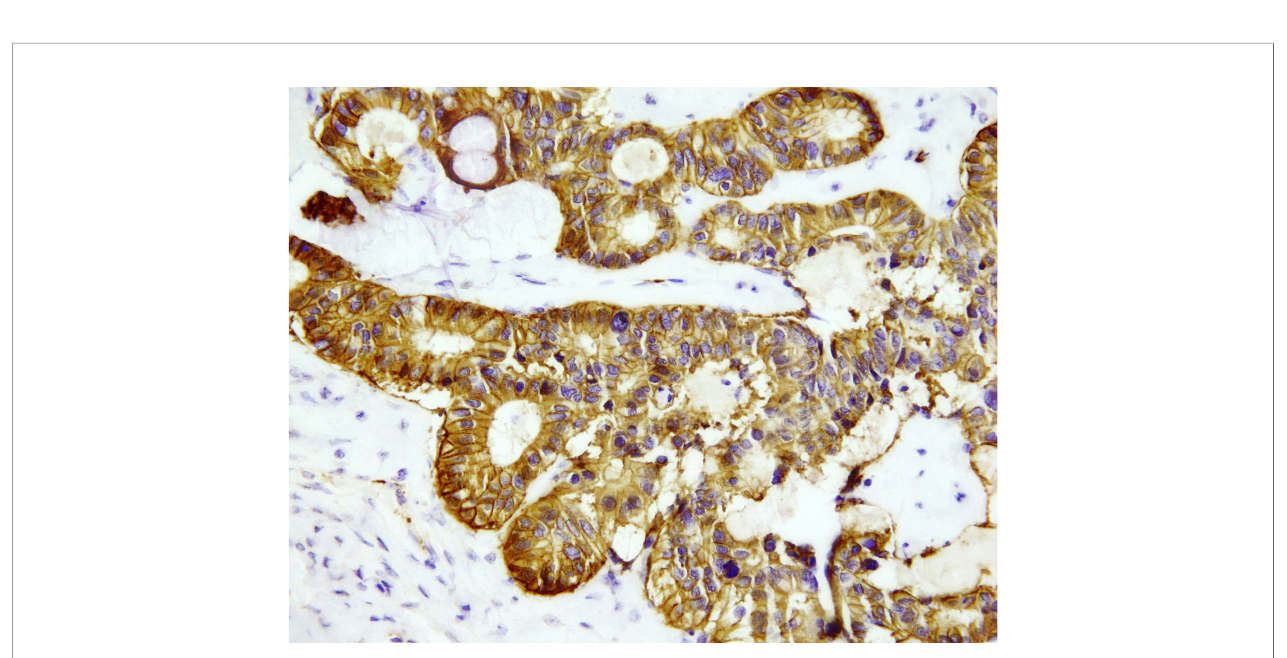
FIGURE 2 | NET focus in teratoma SSTR 2 expression, zoom 40x. Immunohistochemical staining with somatostatin receptor SSTR2: all cells show positive membrane